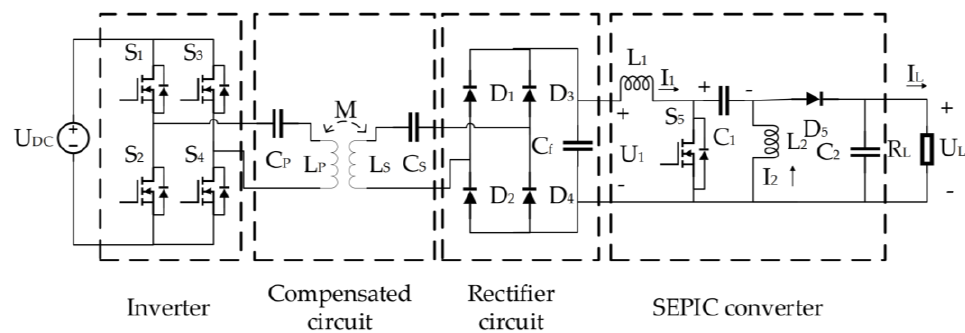
Figure 6. S – S IPTS with passive rectifier and SEPIC post-regulator